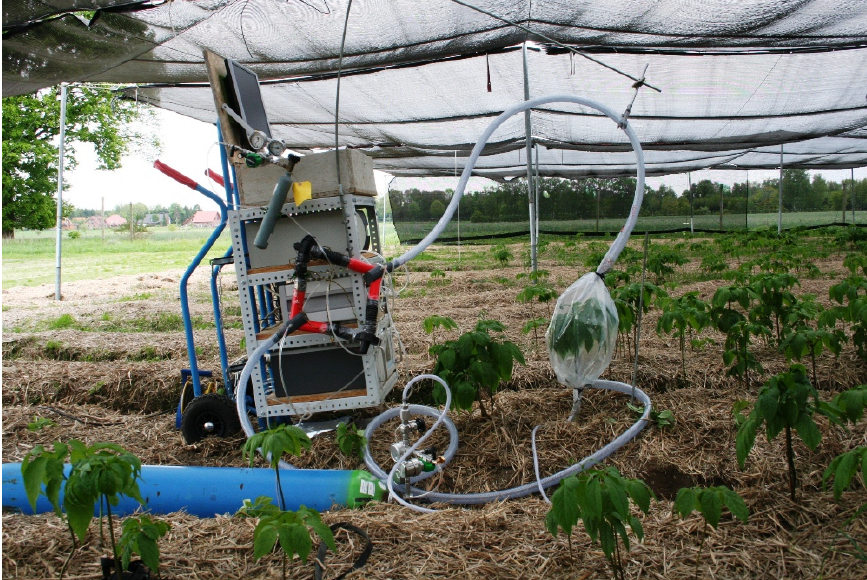
Figure 2. The portable unit used in this study for controlled incubation of P. ginseng with 13 CO under field conditions. 2